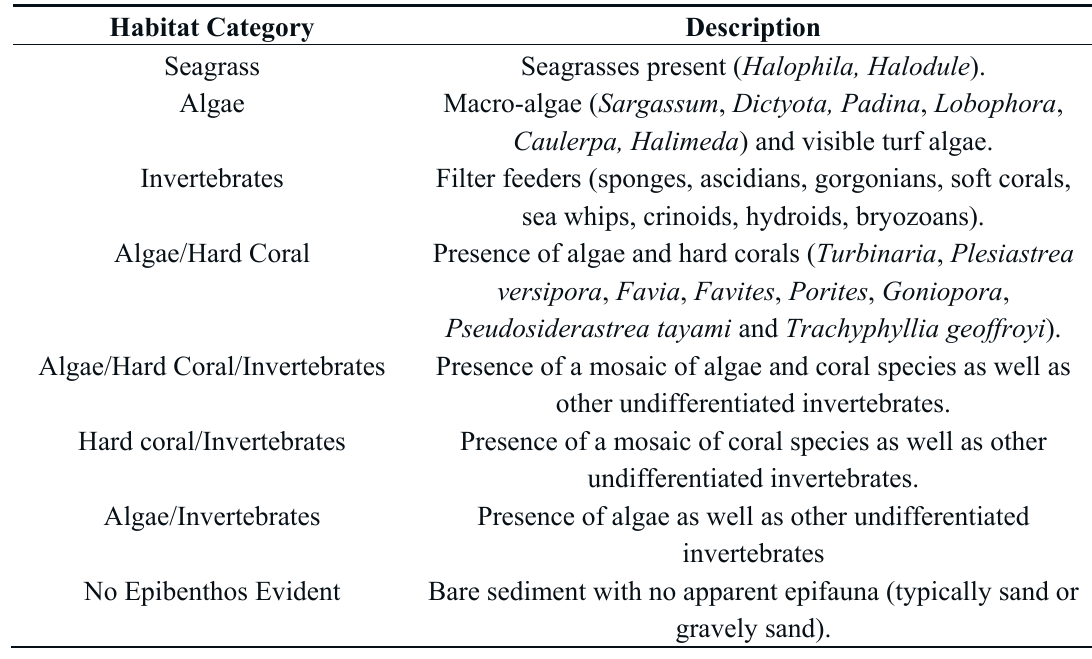
Table 2. Habitat classification scheme used to categorise the video (ground truth) dataset. The habitat categories listed will inform the habitat